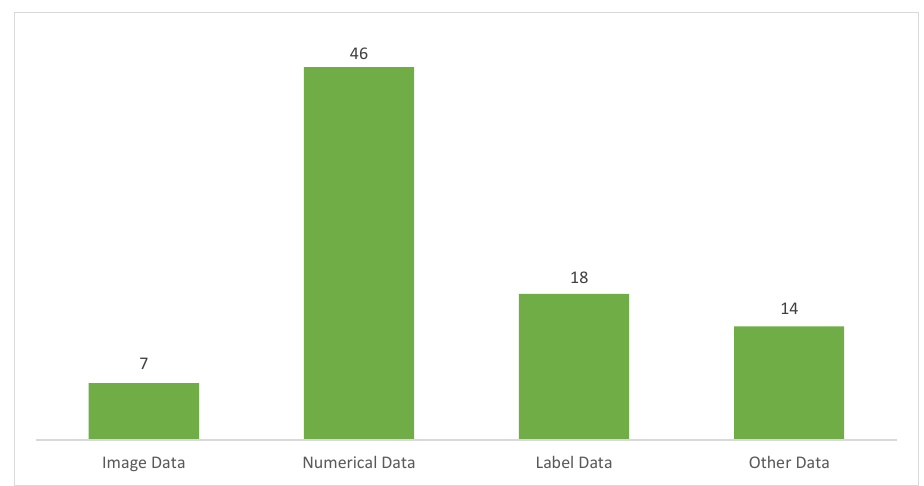
Figure 2. Number of datasets ( y -axis) divided by data type ( x -axis).